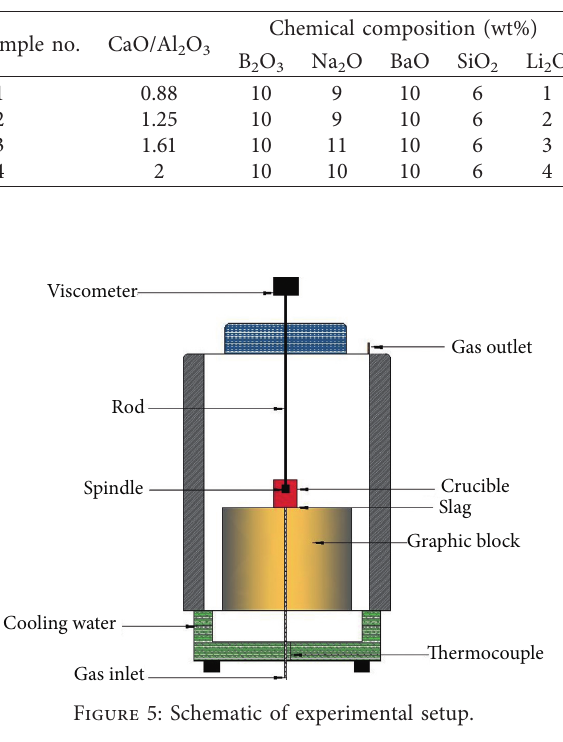
Figure 5: Schematic of experimental setup.